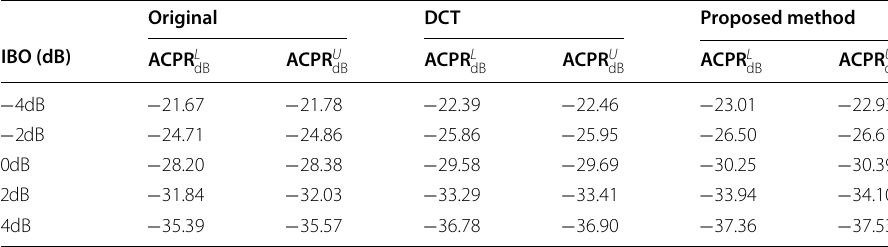
Original DCT Proposed